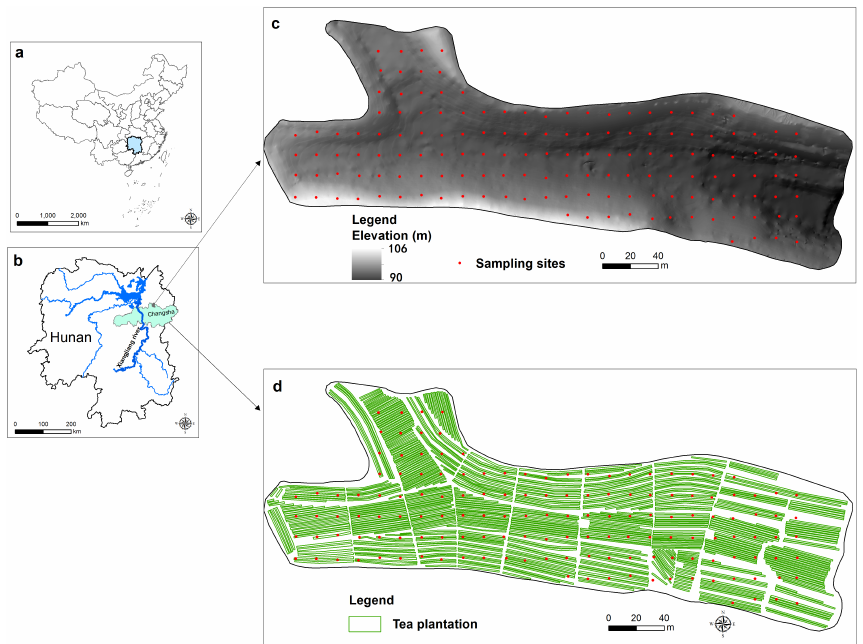
Figure 1. (a, b) Location and (c, d) digital elevation model and land use map of the tea-planted catchment. The red circles in (c) and (d) represent the sample points. The catchment is located in the town of Jinjing, which is 70km northeast of Changsha, the capital city of Hunan Province,